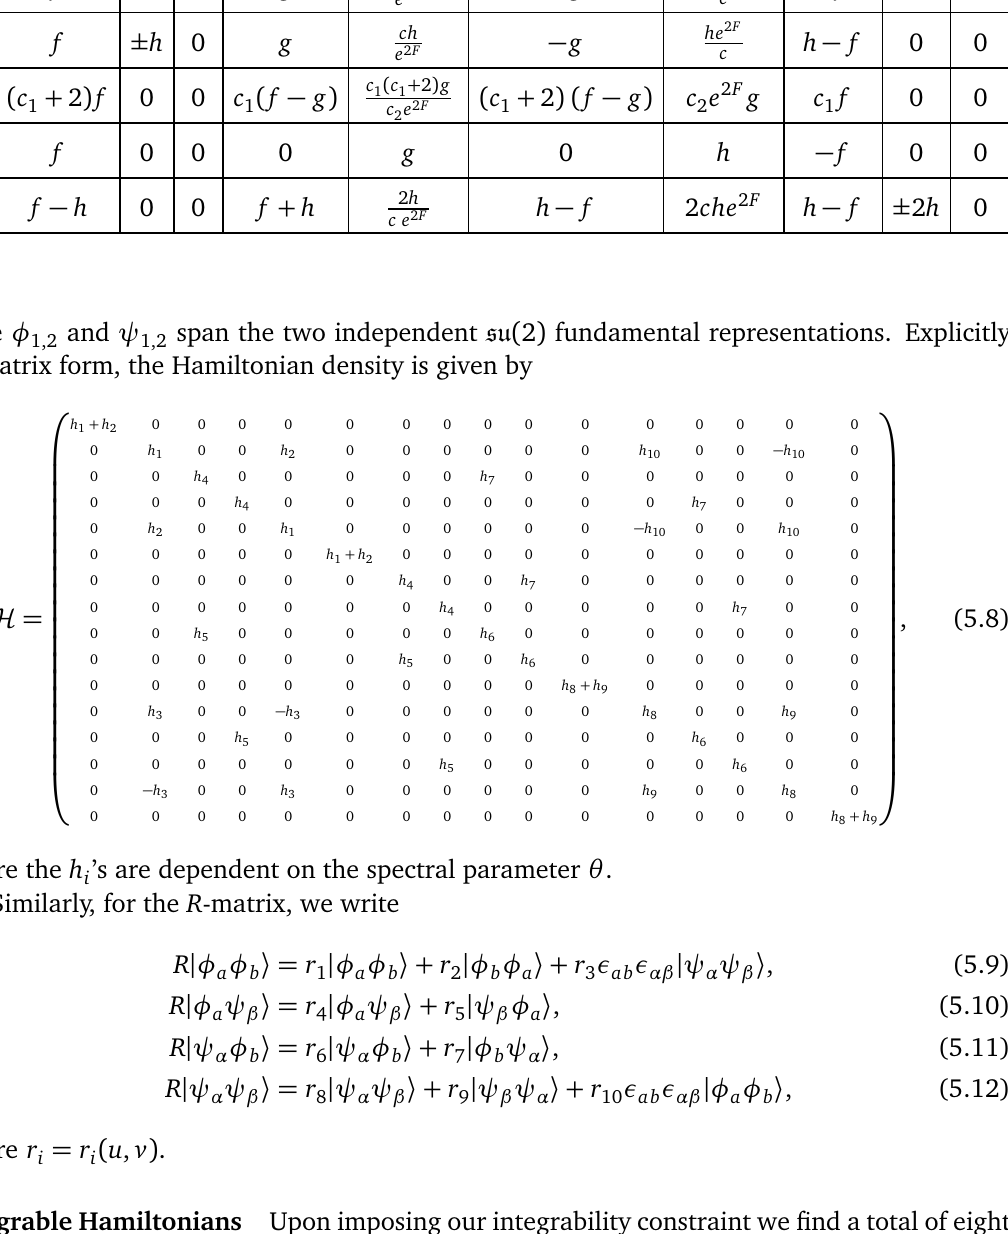
= 0. We denote constants by c , c 3